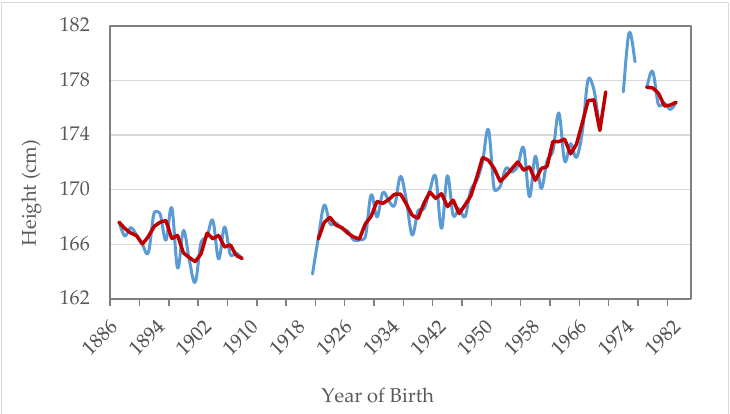
Figure 5. Annual average heights in SB. Cohorts 1886–1982. Estimate with 3rd order moving averages. (MM3). Source: AMSB, ACDS. Own work.